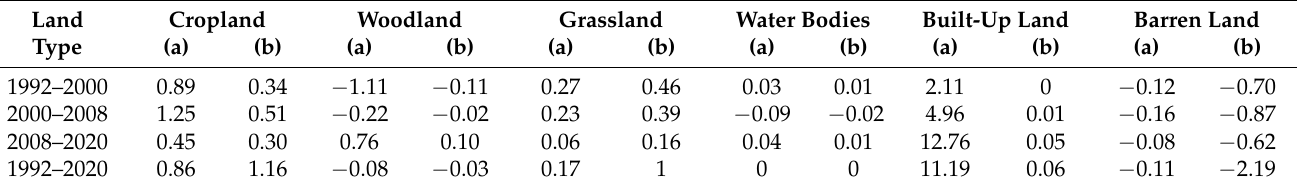
Table 1. Land use dynamics/intensity in the Tarim River Basin, 1992–2020 (%). (a) Land use